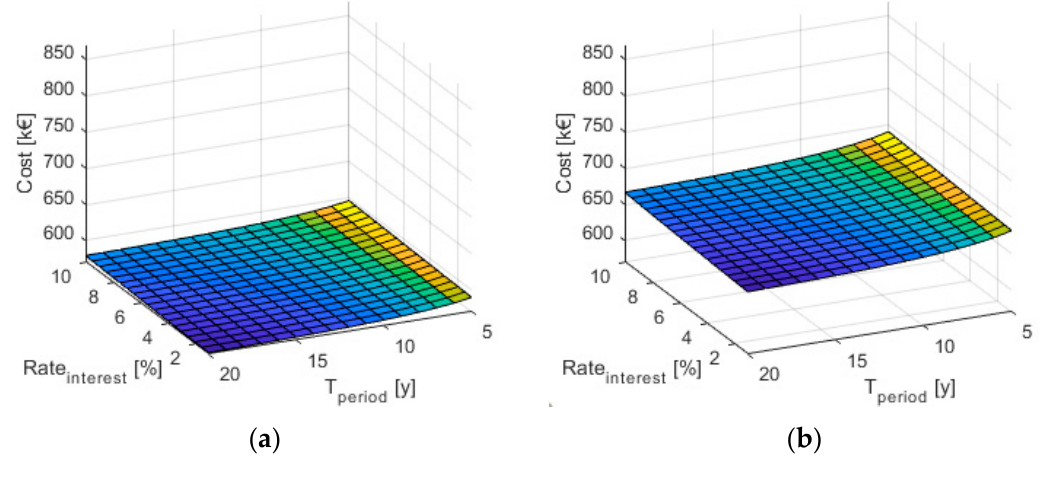
Figure 11. Minimum annual total cost for the best solution for power plant without redundancy: ( a ) without reliability considerations; ( b ) minimum annual total cost for the best solution with reliability considerations.